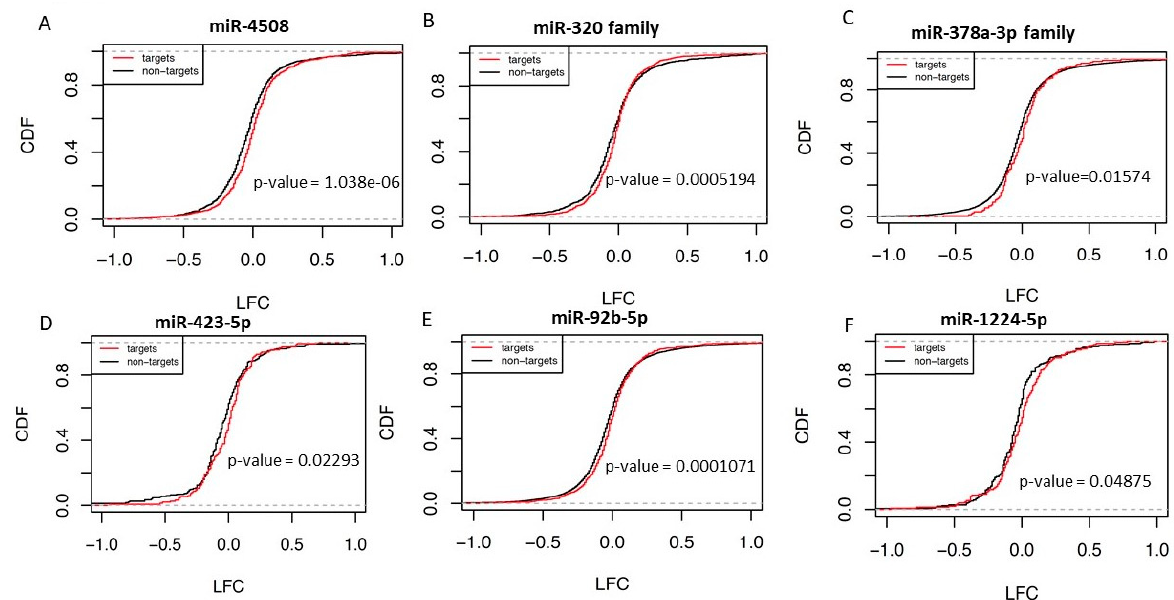
Figure 4. Volcano plot showing the differentially expressed miRNAs in TG compared to normal allograft function. Significant changes with logFC > 1 with FDR ≤ 0.1 are labeled red.